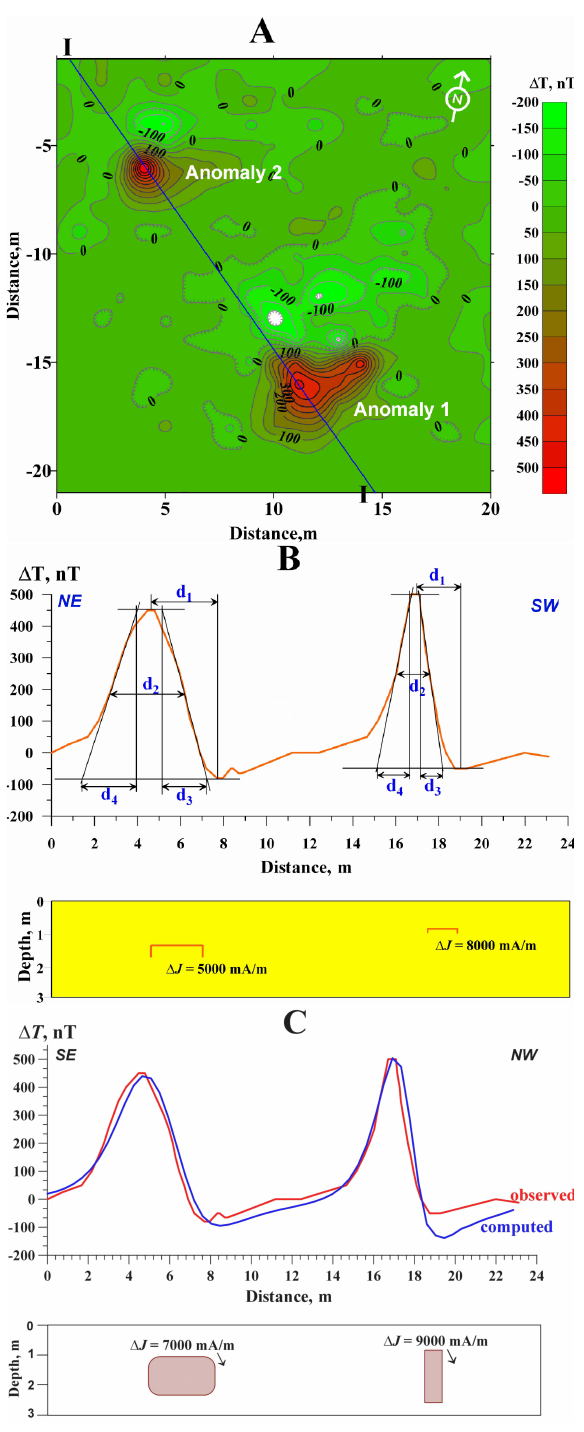
Fig. 12. Solving inverse problem and 3-D modeling of magnetic field in the Tel Kara Hadid site (Southern Israel): ( A ) Magnetic map of the studied site, ( B ) Rapid interpretation of magnetic anoma- lies using developed procedures along the profile I–I. 1J denotes the effective magnetization. ( C ) Results of 3-D modeling. Arrows show the determined position of the total magnetic field